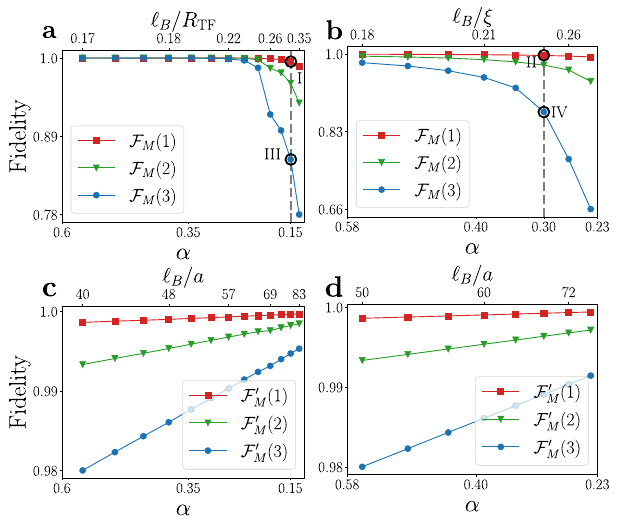
Fig. 10 Dependence of the fi delity on the strain strength. a , b Fidelity F M as a function of α ( ℓ B ) for a the Thomas – Fermi regime with an onsite interaction U = 10 − 4 J , a strength of harmonic con fi nement V x = 10 − 6 J / a 2 , and a number of bosons N ↑ = 1.2 × 10 5 and for b the non-interacting regime with U = 0, V x = 5.8 × 10 − 11 J / a 2 , N ↑ = 4.8 × 10 5 . In c , d we compute the fi delity F 0 M to check the validity of the continuum description as a function of α ( ℓ B ) for the same parameters as in a and b , respectively. The wavefunctions of the dots indicated by roman numbers in a and b are taken as representative examples that are shown in a separate fi gure.